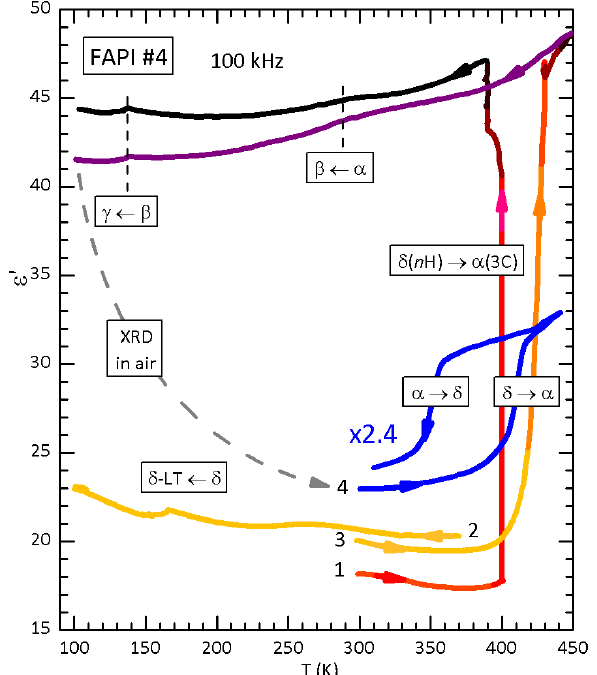
Figure 4. Dielectric permittivity of FAPI measured at 100 kHz. Curves 1–3 were presented in Figure 1 of Reference [19]. Curve 4 is rescaled for clarity, but it should start at ε (cid:48) = 18 − 20. Adapted with permission from ref. [19]. Copyright (2020) American Chemical